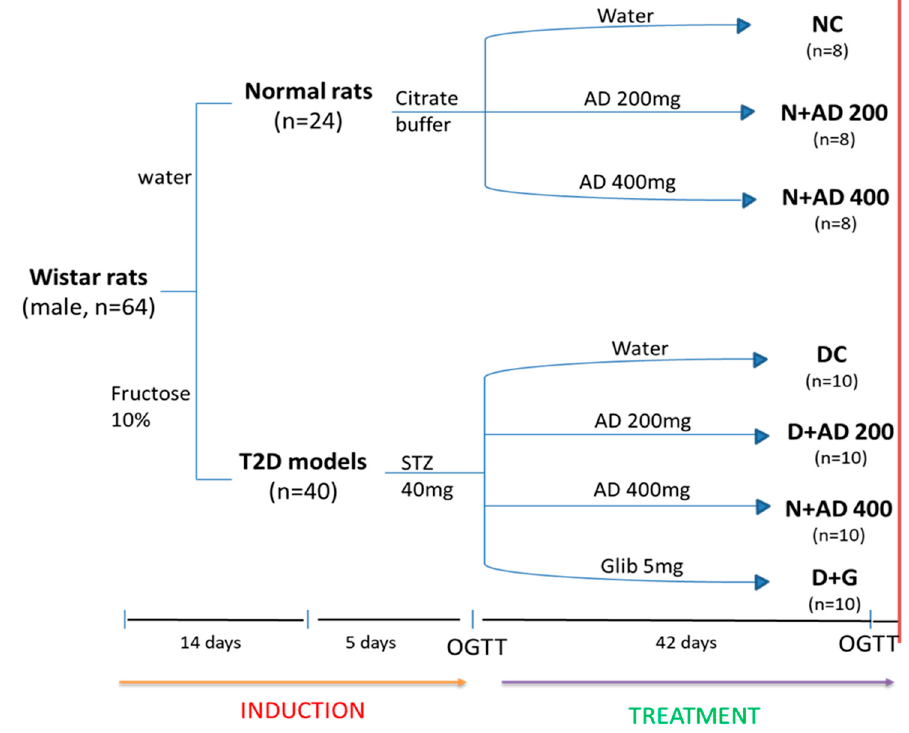
Figure 11. Experimental design. Animals were randomly assigned into 7 groups (n ≥ 8). 14 days administration of 10% fructose preceded a single-dose injection of STZ (40 mg/kg). After 5 days, animals with fasting blood glucose of 15 mmol/L or greater were considered diabetic. OGTT was conducted to confirm insulin resistance. Normal rats were administered the vehicle; water and citrate buffer (CB) correspondingly. Treatment commenced immediately for 42 days via oral gavage. Animals were euthanized on the 43rd day (red bar).